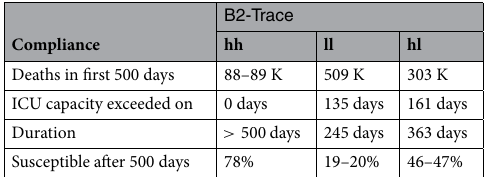
Table 8. Results for the benchmark scenario B2 with tracing.